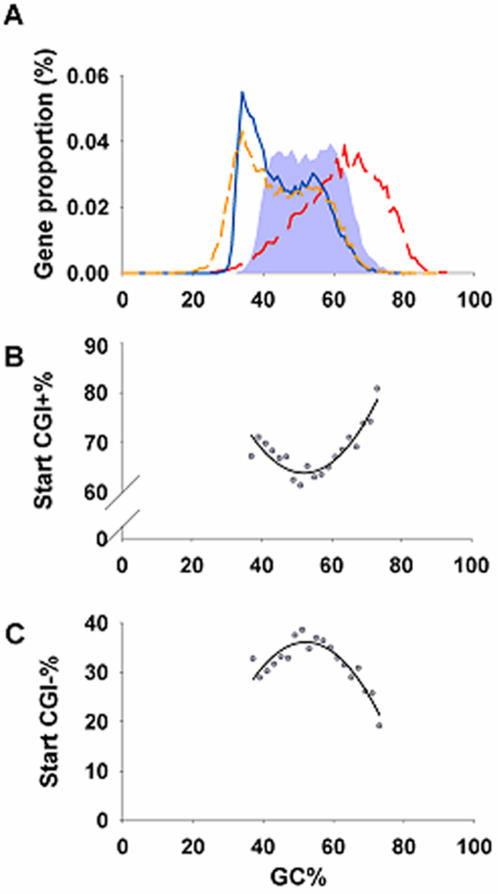
Biphasic GC/AT distribution of PCI+ genes. A, Distribution of GC content among different regions of genes (coding region, grey fill; intronic, black solid; 5¢ untranslated region, dark grey, long dash; 3¢ untranslated region, grey, short dash).B&C, Proportion of genes among different GC groups; B, with ‘start’ CpG islands (CGI+). C, without ‘start’ CpG islands (CGI-).